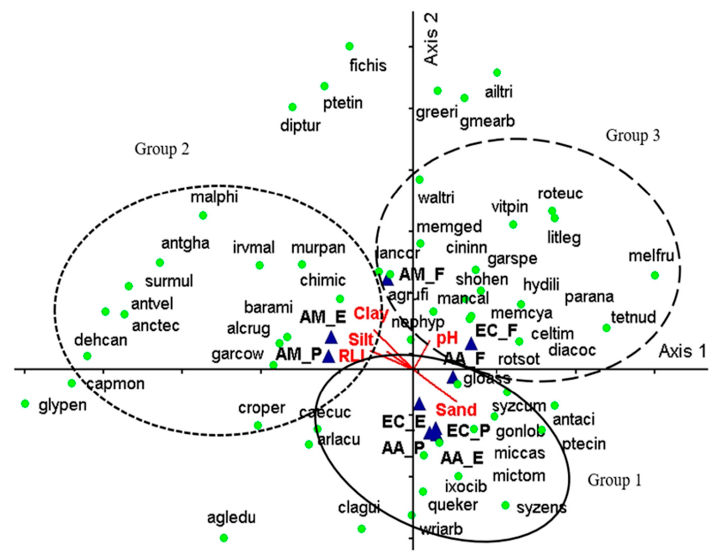
Figure 8. The CCA ordination diagram representing the relationship between the distribution of native tree species and the environmental factors: sand, silt, and clay particles, soil pH, and relative light intensity (RLI) along the forest remnants to plantation stands of three exotic plantations. EC: Eucalyptus camaldulensis , AA: Acacia auriculiformis , AM: A. mangium . A filled triangle ( (cid:78) ) represents each stand, and a green circle ( ) indicate the distribution of species against Axis 1 and Axis 2. Table 4. Results of the canonical correspondence analysis (CCA) of the relationship between tree species and the environmental factors.